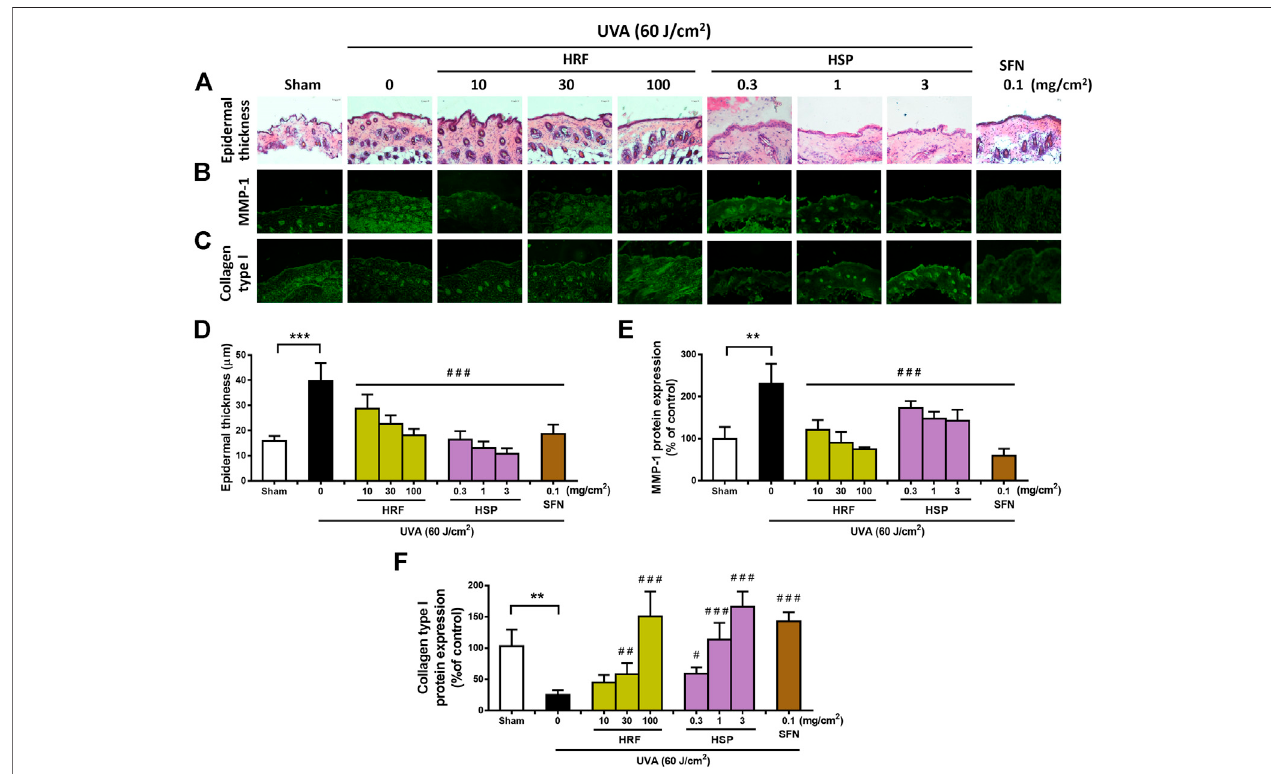
FIGURE 4 | The protective effects of HRF and HSP on UVA-induced skin damage in the in vivo model. BALB/c mice were topically applied with 10, 30, and 100 mg/cm 2 HRF and 0.3, 1, and 3 mg/cm 2 HSP as well as the ethanol treatment and no compound treatment (0) on the dorsal skin for 1 h prior to each UVA irradiation (10 J/cm 2 /session 3 times a week for 2 weeks; a cumulative total dose of 60 J/cm 2 ). Images of H&E staining for epidermal thickness (A) and the immuno fl uorescence of MMP-1 (B) and collagen (C) werecollected at24 h following thelast UVA exposure. The summary graph with the statistical analysisof epidermal thickness (D) and the protein levels of MMP-1 (E) and collagen (F) was quanti fi ed by ImageJ and GraphPad Prism software. Data was shown as mean ± SD at the × 20 magni fi cation (scale bar (cid:1) 50 μ m), n (cid:1) 4. ** p < 0.01, *** p < 0.001 vs. non-irradiated sham group by Student ’ s t -test. #p < 0.05; ## p < 0.01; ### p < 0.001 vs. the sham-irradiated group by one-way ANOVA Dunnett ’ s